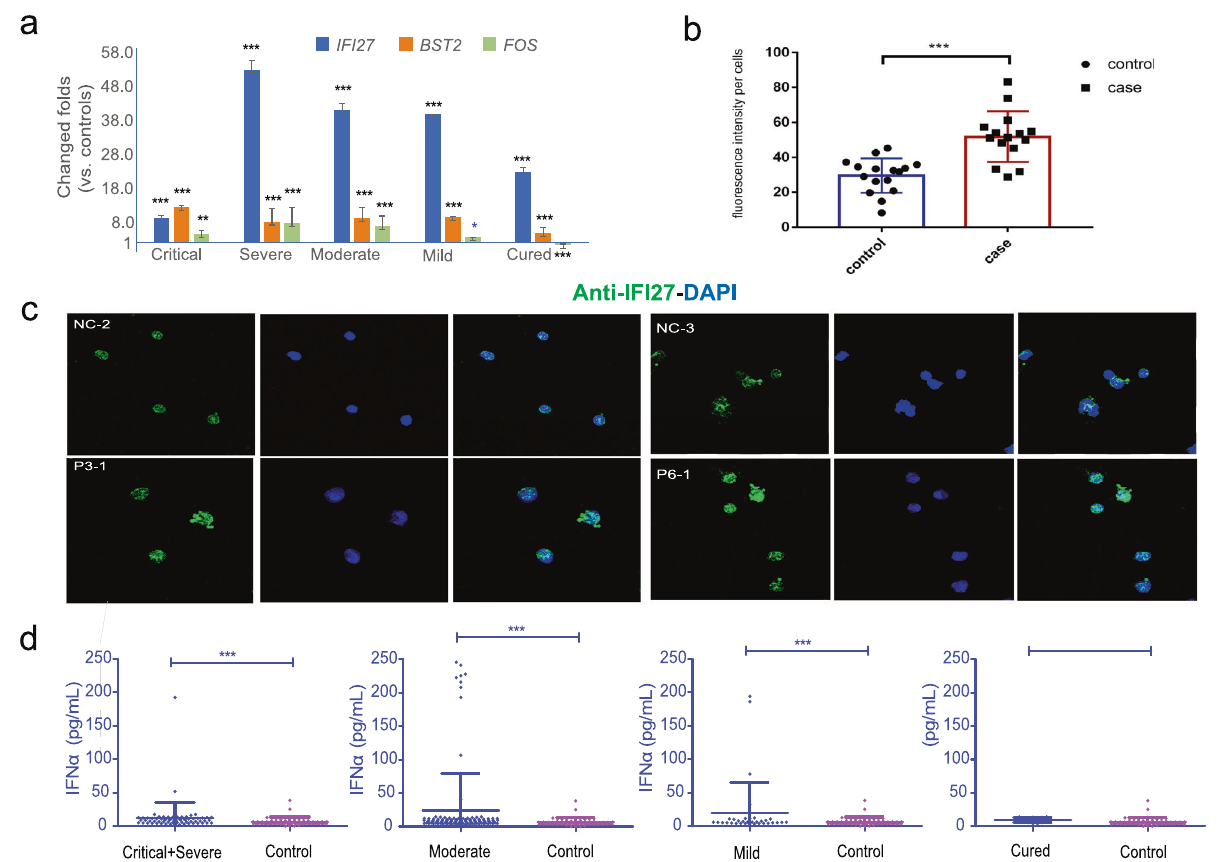
Fig. 6 Experimental validation of IFN-I signaling. a Real-time PCR validation of IFI27 and BST2 in the interferon pathway and FOS in the MAPK pathway. IFI27 and BST2 are upregulated in patients with COVID-19. FOS is upregulated in hospitalized patients but downregulated in cured patients ( N = 3 for critical, N = 3 for severe, N = 19 for moderate, N = 3 for mild, and N = 10 for cured patients with COVID-19 and 35 normal controls). * P < 0.05, ** P < 0.01, *** P < 0.001; Student ’ s t -test. b Statistical signi fi cance of IFI27 immuno fl uorescence signal comparing COVID-19 and normal controls. *p < 0.05; **p < 0.01; *** p < 0.001. c Immuno fl uorescence staining of IFI27 in PBMCs of patients with COVID-19 and normal controls. d IFN- α concentration in serum of 257 patients with COVID-19 and 106 matched tested by ELISA, including of the severe and critical group (12.02 ug/mL ± 2.80, N = 68), the moderate group (23.99 g/mL ± 4.840, N = 133 patients), the mild group (20.29 ug/mL ± 7.732, N = 34 patients), and the cured group (9.637 ug/mL ± 1.184, N = 22 patients). * P < 0.05, ** P < 0.01, *** P < 0.001; one-way